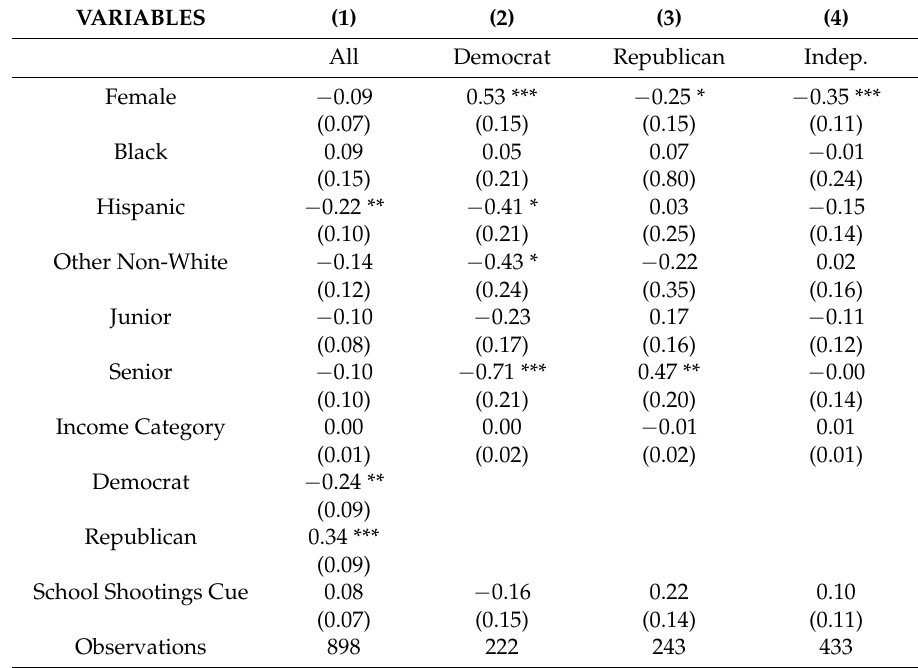
Table 4. Emotional cues and attitudes towards arming citizens. Ordered probits: dependent variable is degree of agreement with the statement that “a greater presence of armed citizens would reduce the risk of mass